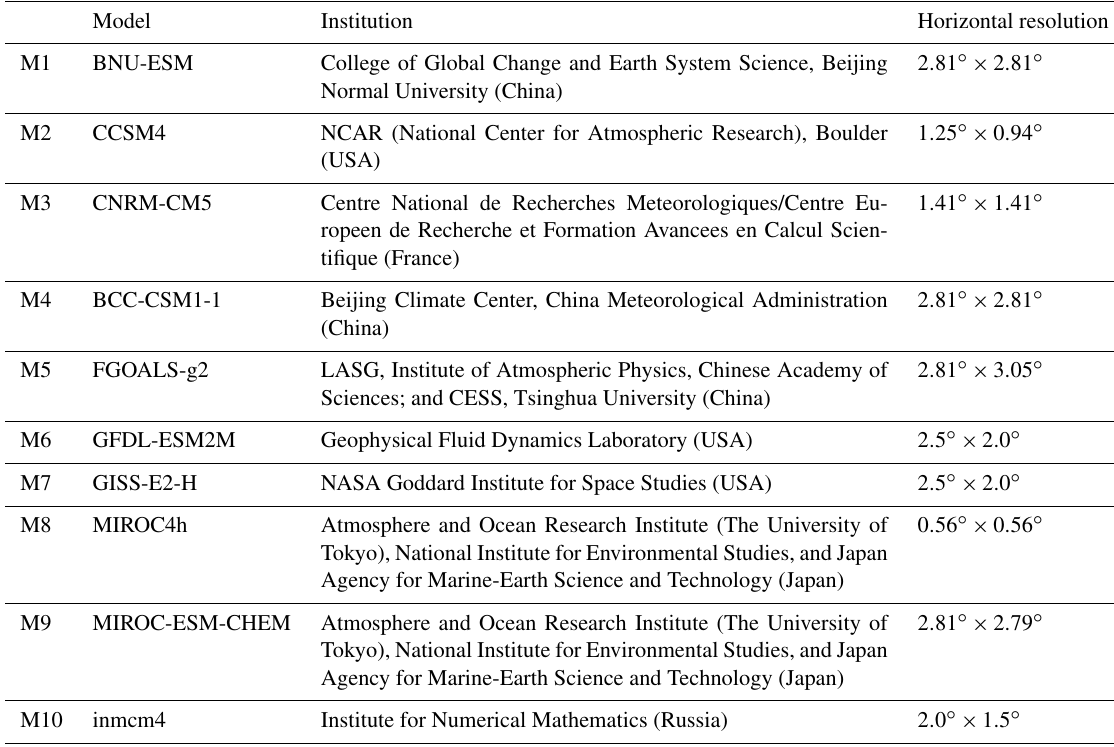
Table A2. Model names, institution, and horizontal resolution for 10 CMIP5 models (M1–M10) used in the paper.